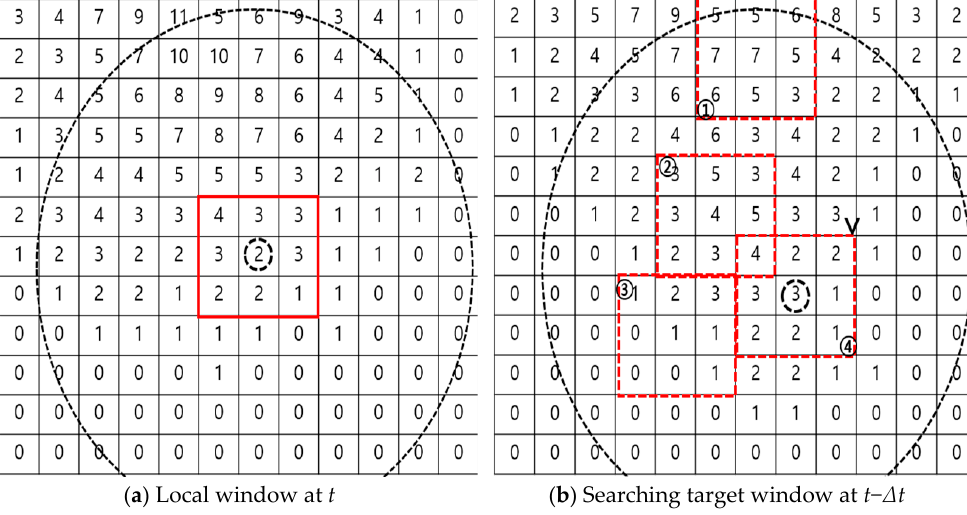
Figure 1. Storm tracking within the search domain (circle) based on the pattern correlation between local window ( a ) and target window ( b ) (the number inside the cell represents rainfall intensity).